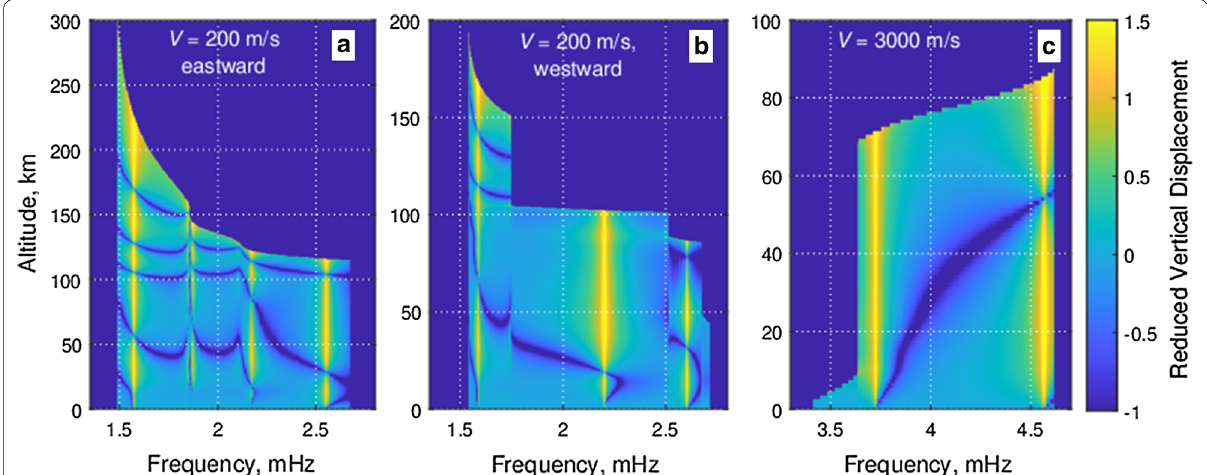
Fig. 4 Response of the atmosphere to monochromatic vibrations of its lower boundary. The amplitude of the reduced vertical displacement is shown on logarithmic scale, log 10 | Q ( z )/ Q (0)|, as a function of altitude and the frequency of oscillations. Displacement amplitude is normalized by its value at the ground level. Atmospheric waves are excited by vibrations that travel a eastward with subsonic trace velocity V 200 m/s; b westward = with subsonic trace velocity V 200 m/s; and c southward at supersonic trace velocity V 3000 m/s. Conditions at Wallops Island, Virginia, on 14 = = July 2014 are assumed in a and b ; conditions at McMurdo, Antarctica, on 15 January 2014 are assumed in